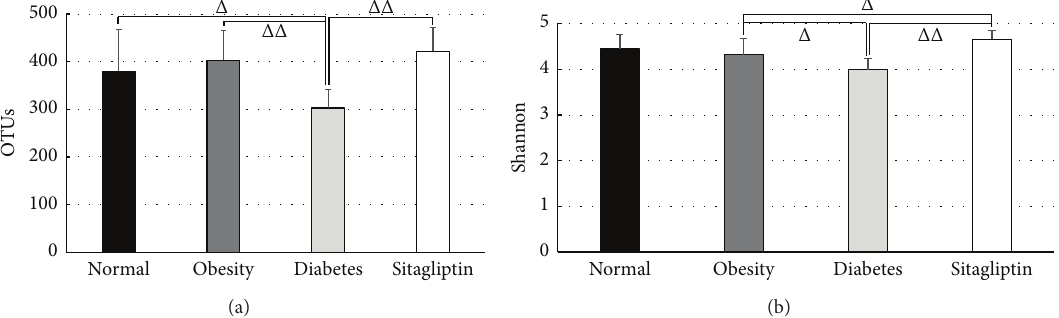
Figure 1: Pyrosequencing data summary: (a) number of OTUs, (b) Shannon (diversity estimator). All data were calculated at 3% distance. Δ 𝑃 < 0.05 , ΔΔ 𝑃 < 0.01 ; data are expressed as mean ± SD.